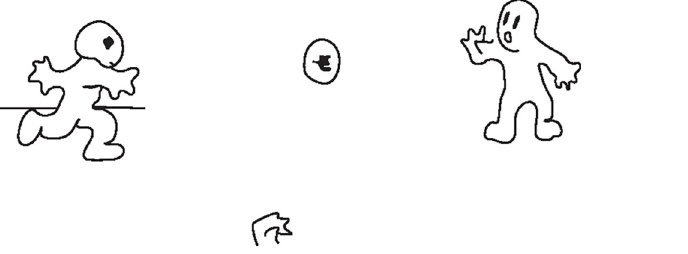
Fig 1. Cyberball game